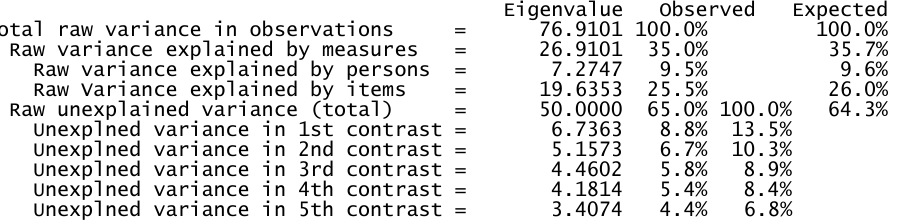
Table 1 . Standardized Residual variance in Eigenvalue units = Item information units Eigenvalue Observed